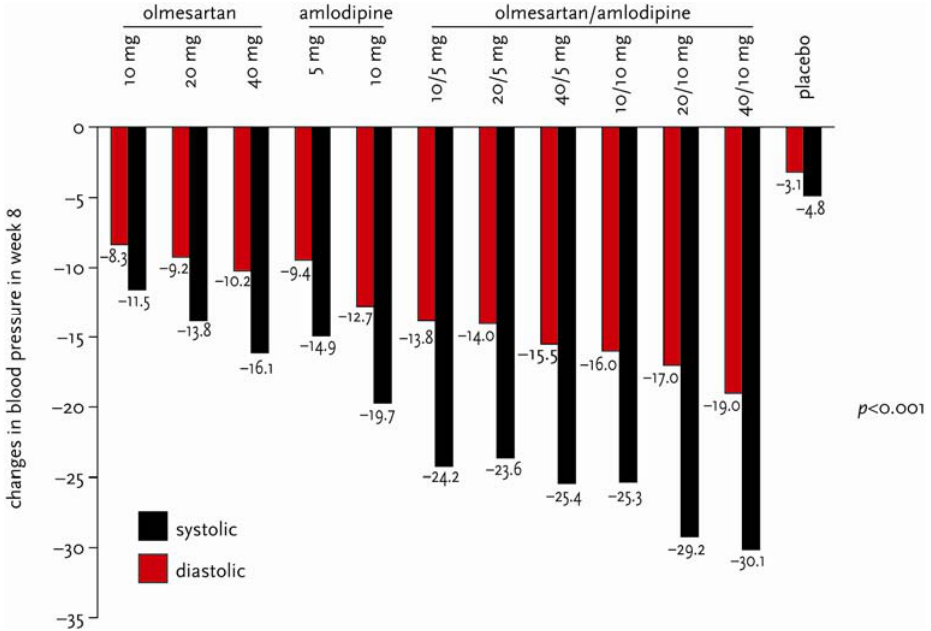
Figure 3. Effect of incremental dosages on diastolic and systolic blood pressure to week eight in 1,940 intention-to-treat patients [13]. Incremental dosages produced dose- dependent decreases of blood pressure. However, the combination therapies produced better decreases than did the monotherapies (p < 0.001 for all equipotent dose